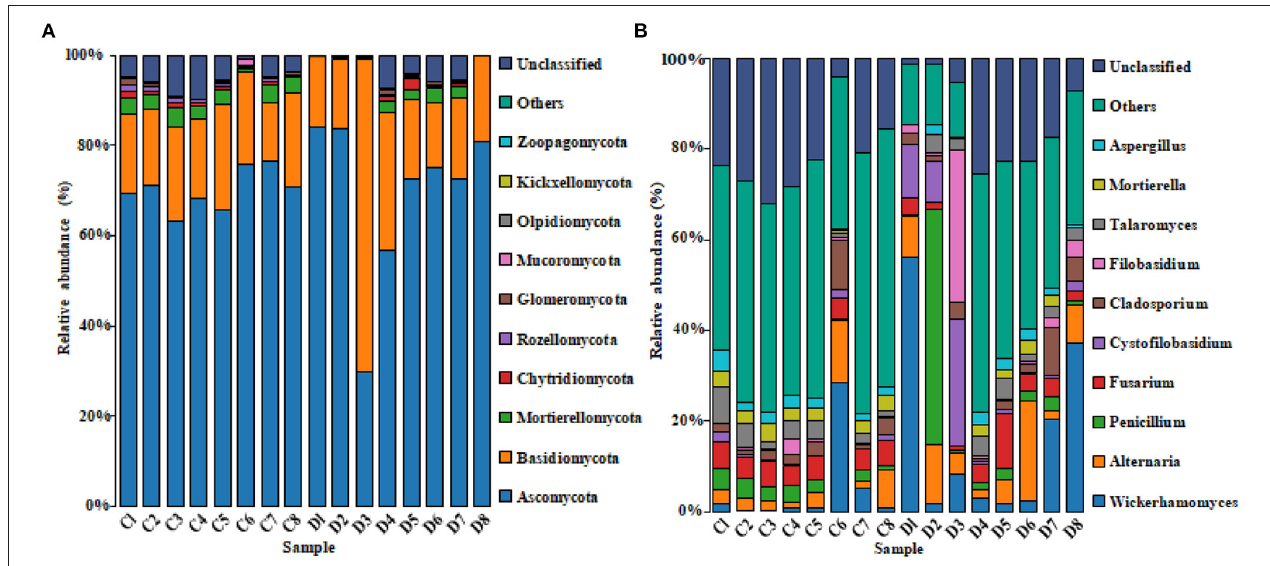
FIGURE 4 | The histogram of the top 10 species distribution at phylum (A) and genus (B) levels.